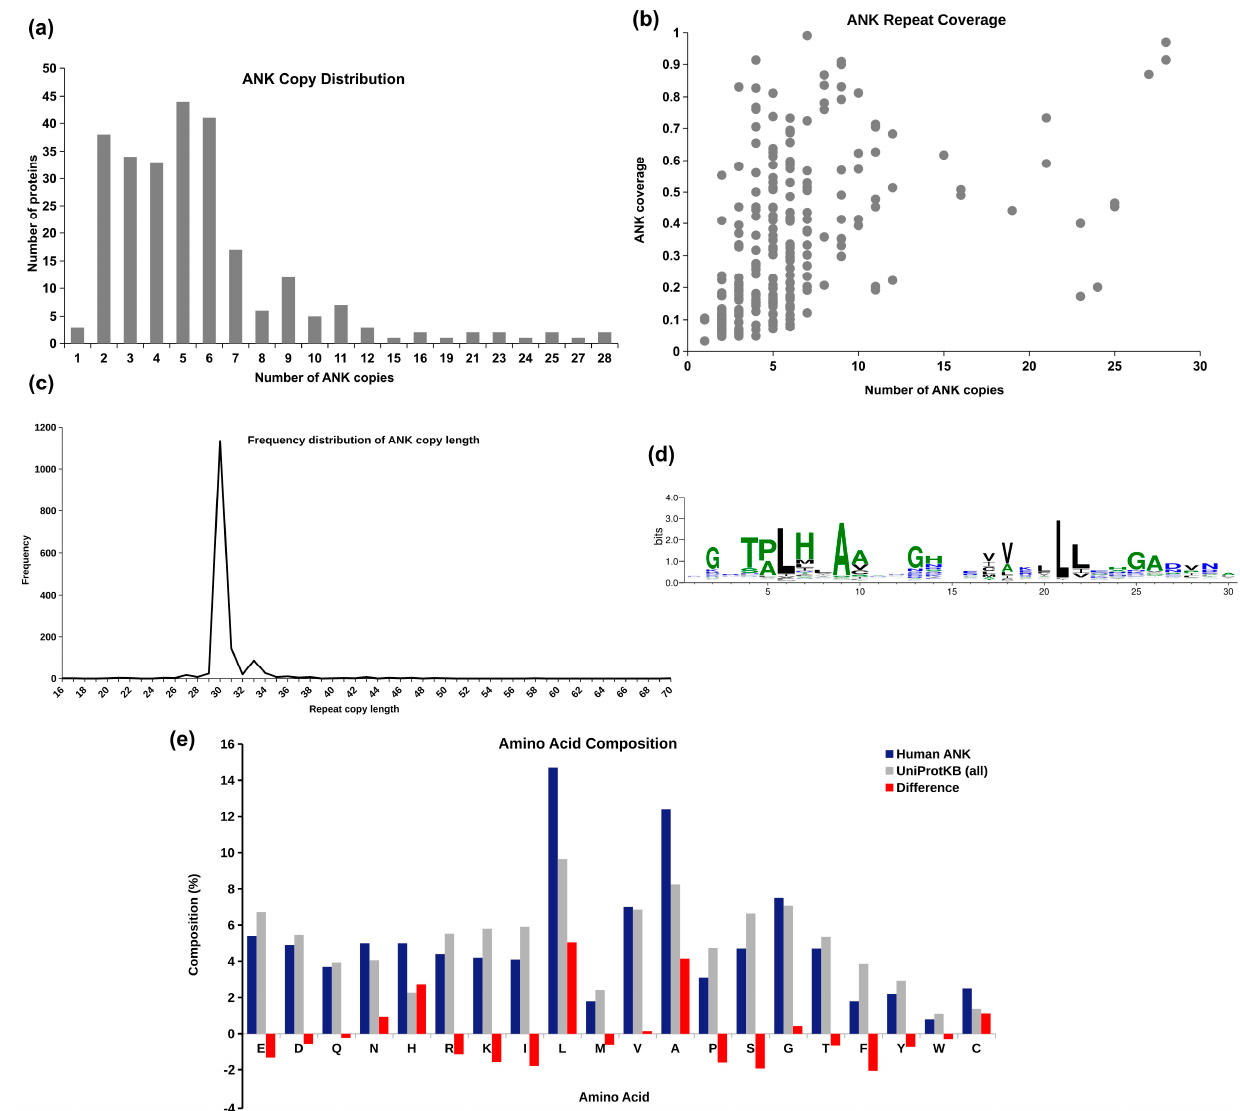
Figure 2. Analysis of 257 human ankyrin repeat proteins in UniProtKB. ( a ) Frequency distribution of the number of ankyrin repeat copies reported in a protein. ( b ) Coverage of ankyrin repeat region compared to the number of repeat copies. ( c ) Frequency distribution of the length of ankyrin repeat unit. ( d ) Sequence logo obtained from multiple sequence alignment of all ankyrin repeat copies. ( e ) Amino acid compositional bias in ankyrin repeat region compared to the base composition in all UniProtKB